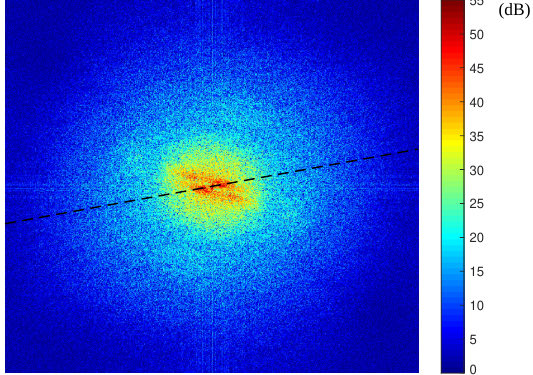
Figure 2. 2D Fourier transform of the SAR image example.